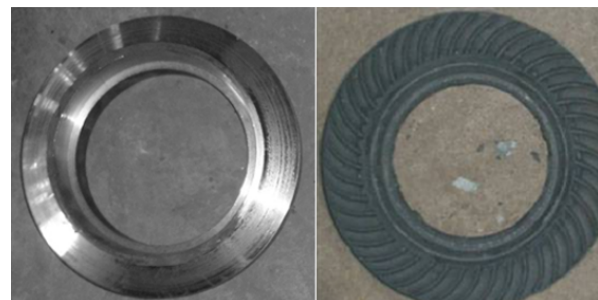
Figure 26. Before and after forming of spiral bevel gear.